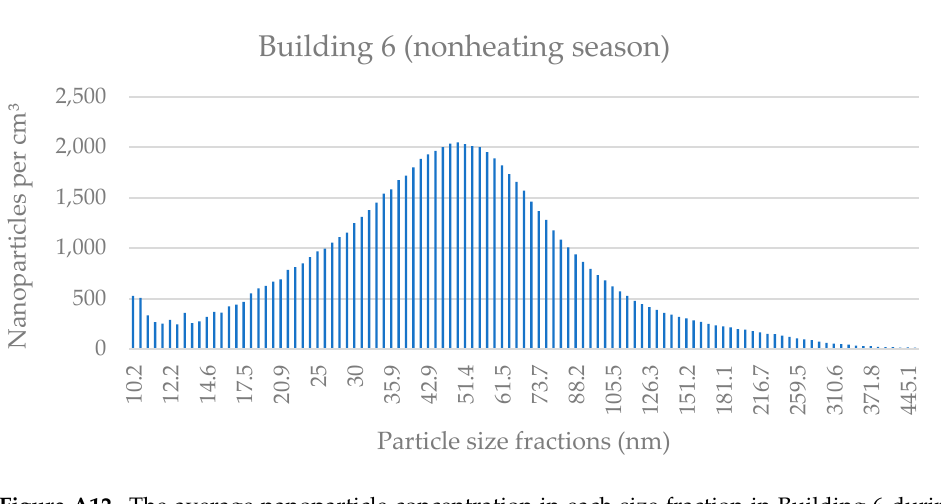
Figure A12. The average nanoparticle concentration in each size fraction in Building 6 during a one-week measurement period during the nonheating season.